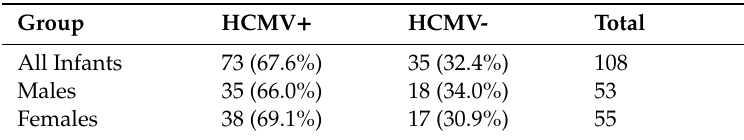
Table 1. Infant numbers according to sex and HCMV